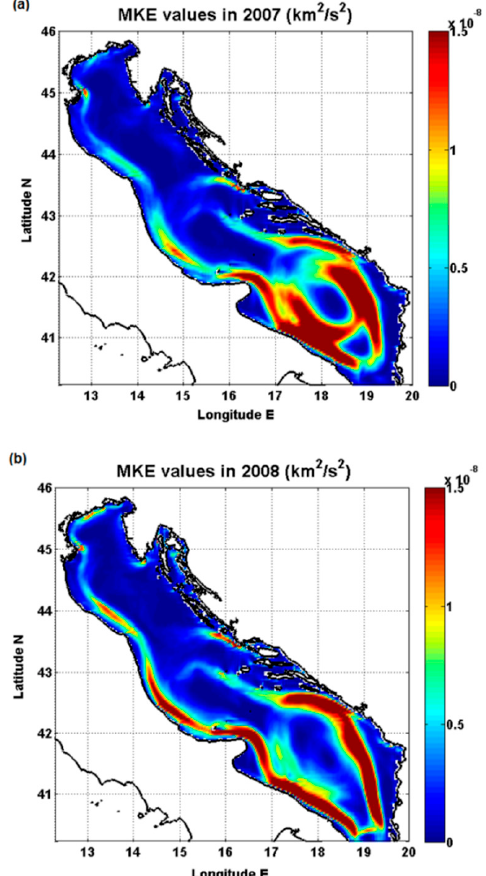
2 ) in 2007 ( a ) and 2008 ( b km 2 s 2 km ) in 2007 ( a ) and 2008 ( b ). 2 s ) in 2007 ( a ) and 2008 ( b ). 2 s